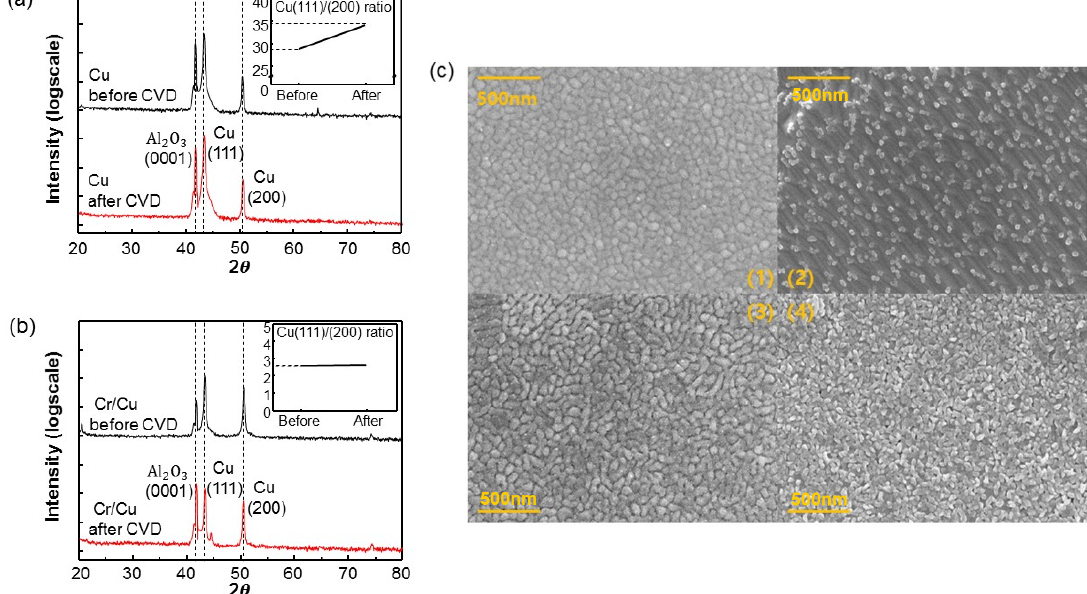
Figure 4. ( a , b ) XRD patterns and SEM images of Cu ( a ) and Cr/Cu ( b ) before and after CVD; ( c ) SEM images of Sapphire/Cu before CVD: ( 1 ), Sapphire/Cu after CVD ( 2 ), Sapphire/Cr/Cu before CVD ( 3 ) and Sapphire/Cr/Cu after CVD (4).